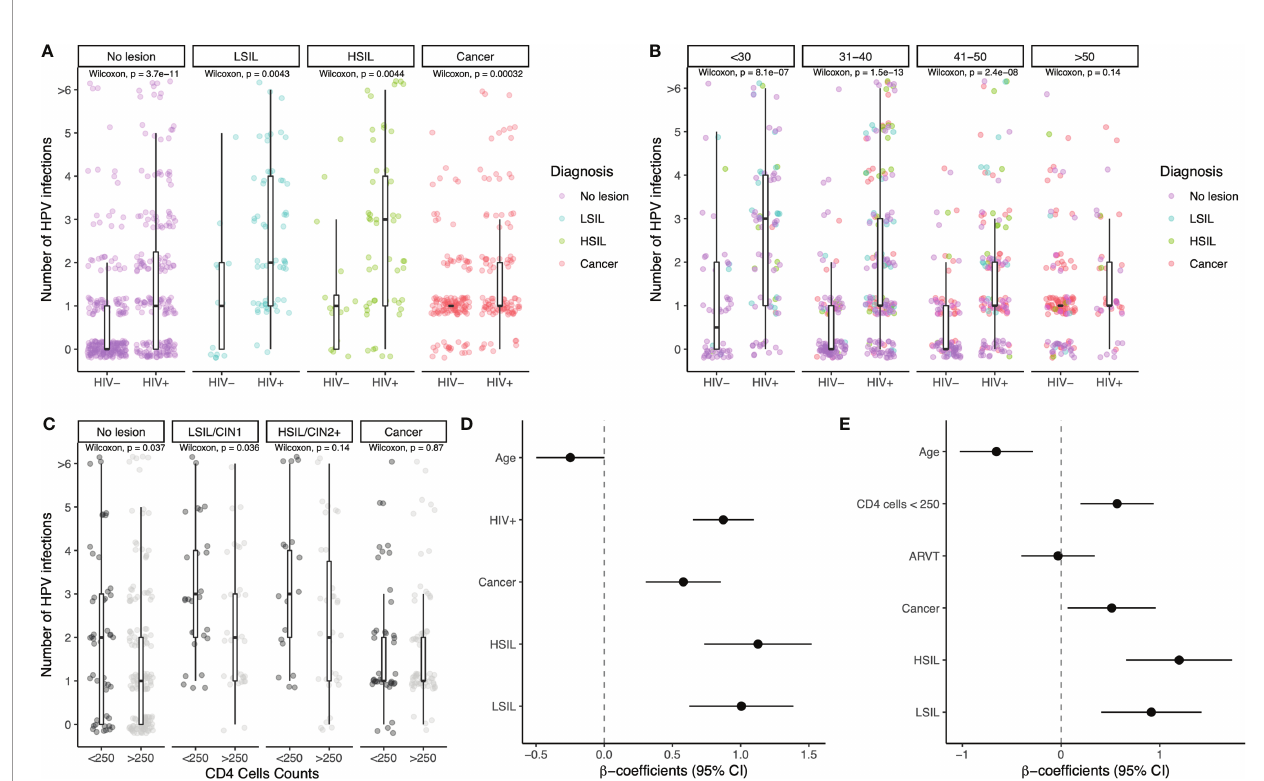
FIGURE 2 | Number of different HPV infections in relation to suspected risk factors. Number of HPV infections strati fi ed by HIV status and cervical lesion status (A) , by HIV status and age groups (B) , and for women living with HIV strati fi ed by CD4 T cell count (below and above 250) and lesion status (C) . Boxplots showing the median and interquartile range as well as outliers are indicated. Statistical analyses were performed using the Wilcoxon test. Multivariate linear regression results with number of HPV infections as dependent variable are shown in (D) for all women, adjusting by age, HIV status, and cytohistological diagnosis, and (E) for women living with HIV, adjusting by age in years, cytohistological diagnosis, number of CD4 T cell count (above vs. below 250), and antiretroviral treatment (no vs. yes). The individual risk factors are indicated on the y-axis; beta-coef fi cients and 95% con fi dence intervals are shown on the x-axis. In order to better visualize different data points that overlap, we used jitter, a graphical representation strategy in the ggplot